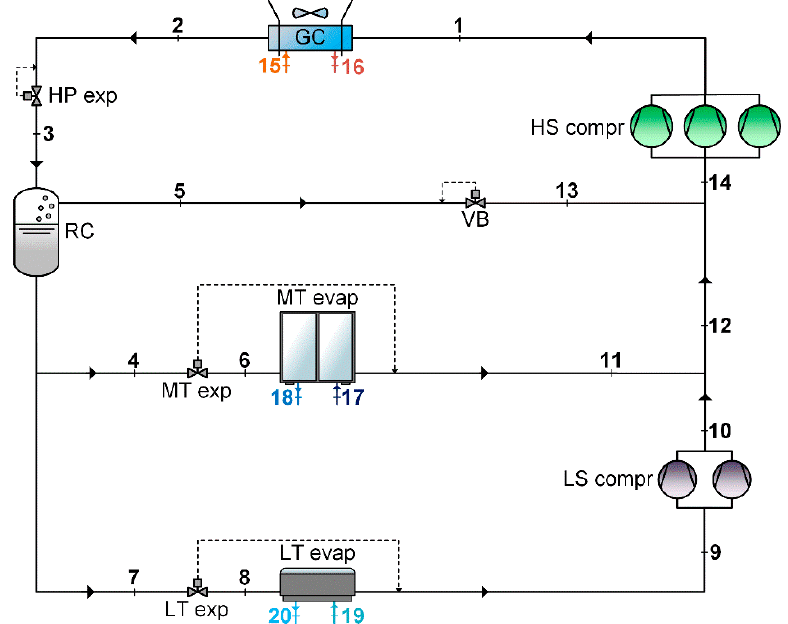
Figure 1. Schematic of a conventional transcritical R744 booster supermarket refrigeration system (CB)